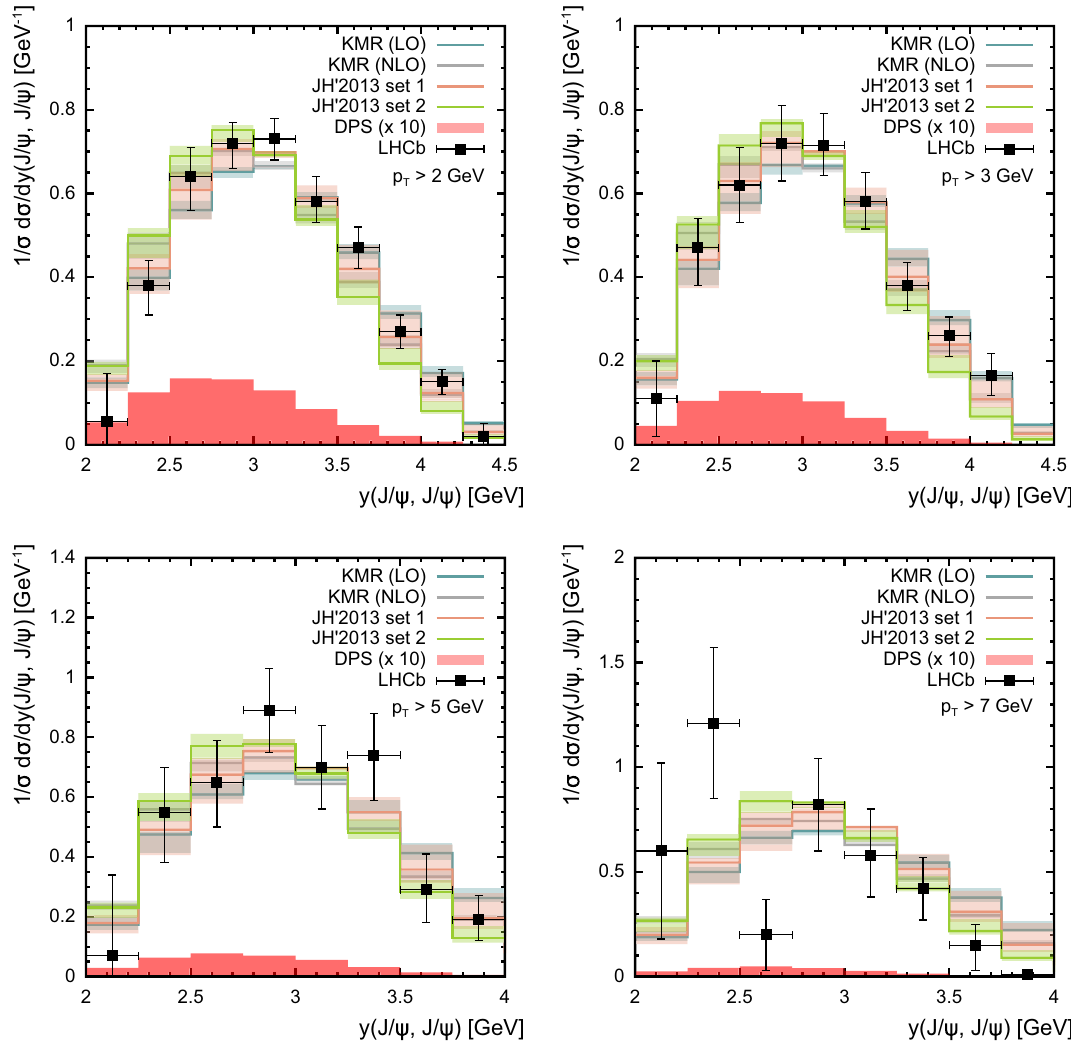
√ s = 8 TeV as a function of the rapidity of the J /ψ